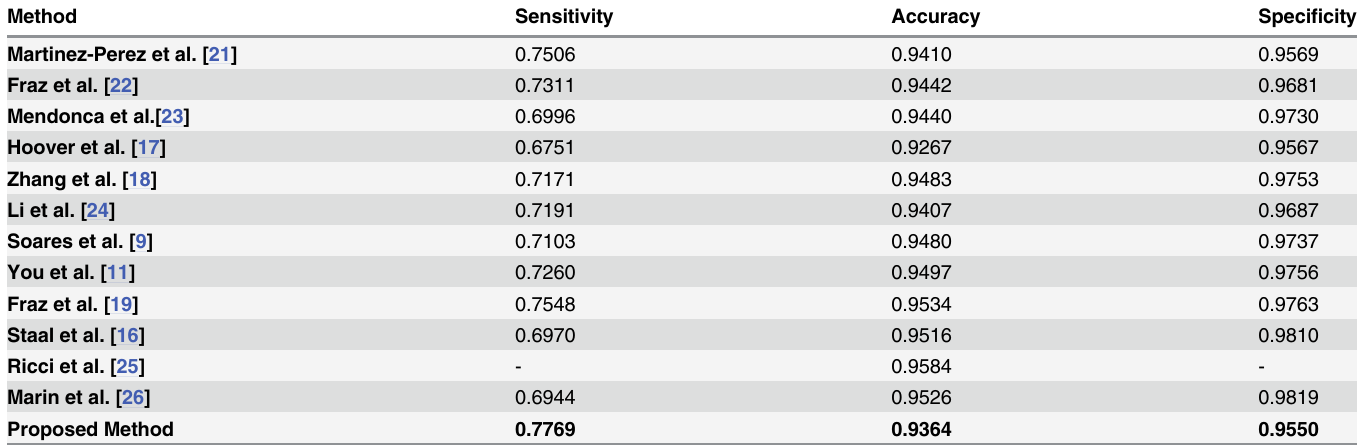
Table 2. Performance of multiple vessel segmentation methods using the STARE dataset (i.e., the first manually segmented